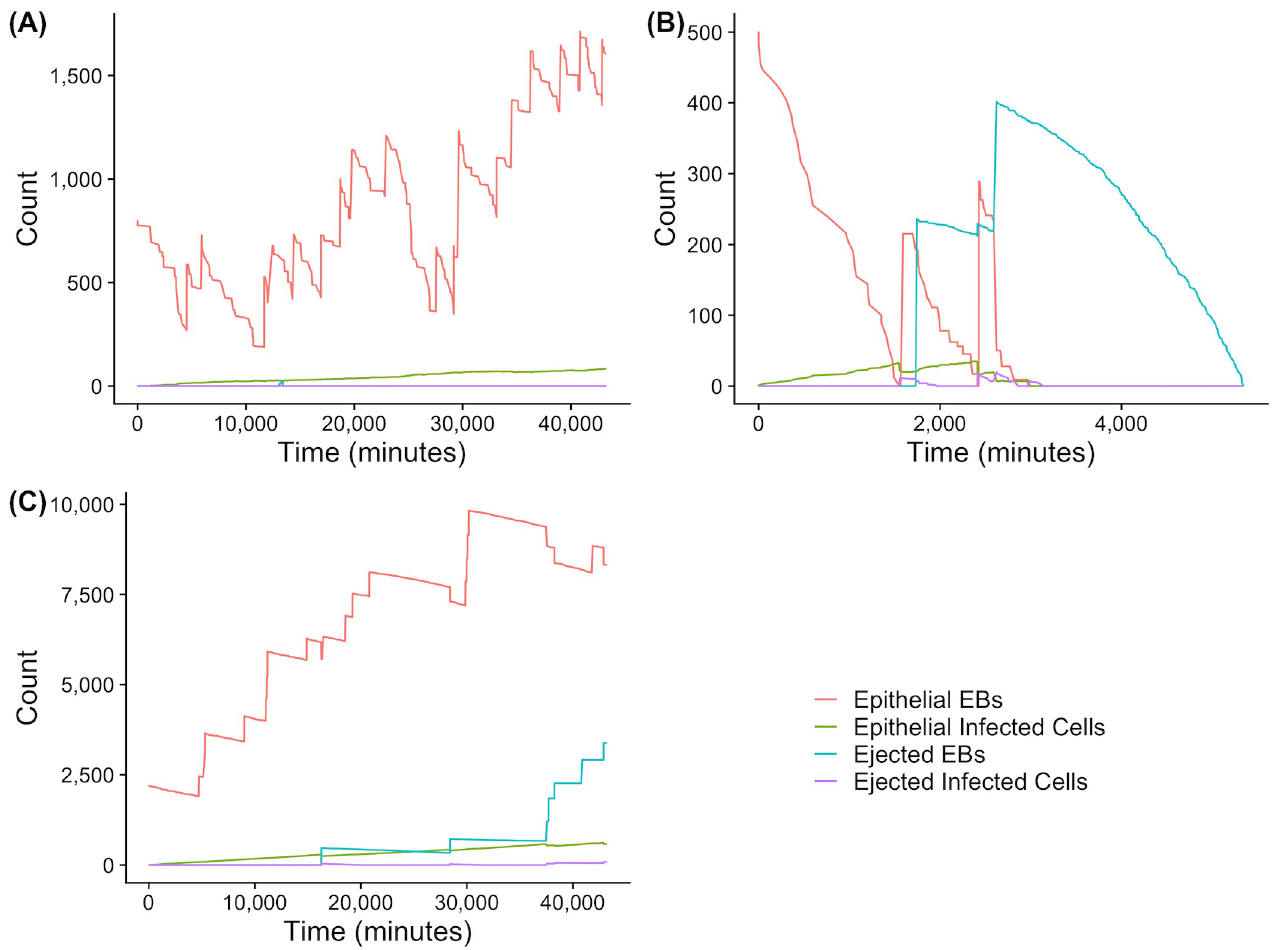
Fig 3. Graphical representation of the counts for each status of elementary bodies and cells in the model under three distinct scenarios over time. The figure shows the outputs of simulated sample paths of the model where factors have been modified. Each figure is a demonstration showing selected representations from the 252, 500 simulations that were conducted. (A) An example output from the model that starter with a load in the range of 801 EBs. (B) An example output of the model starting with a low initial load of 501 EBs. (C) An output that commended with a higher load than A and B of 2201 EBs. Each figure shows a graphical representation of count of each cell/chlamydia form represented on the y axis with the actual counts of Chlamydia trachomatis in the different forms indicated by the coloured lines (see figure legend bottom right), and time in minutes (x axis).